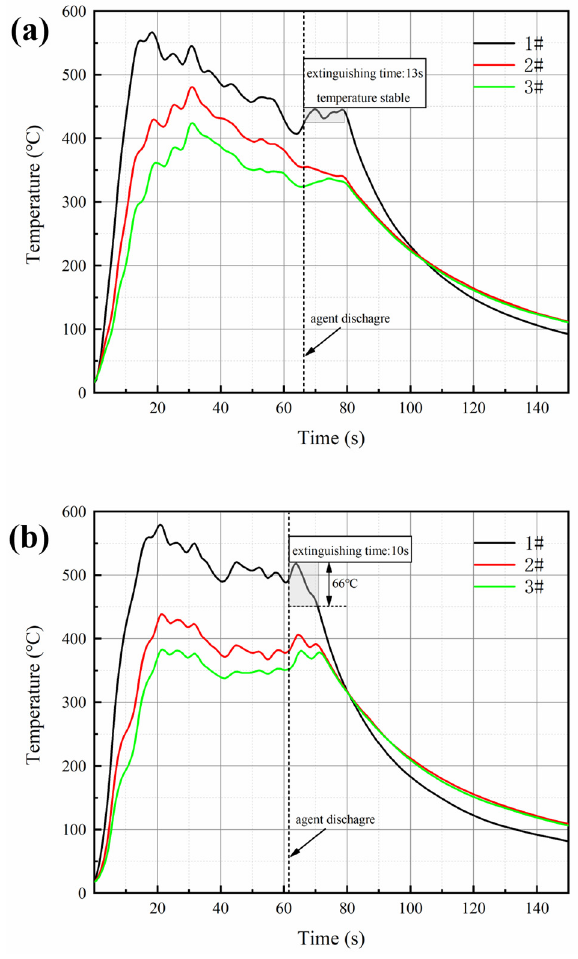
Figure 7. Temperature variation of ( a ) ultrafine NH 4 H 2 PO 4 powder and ( b ) ultrafine struvite